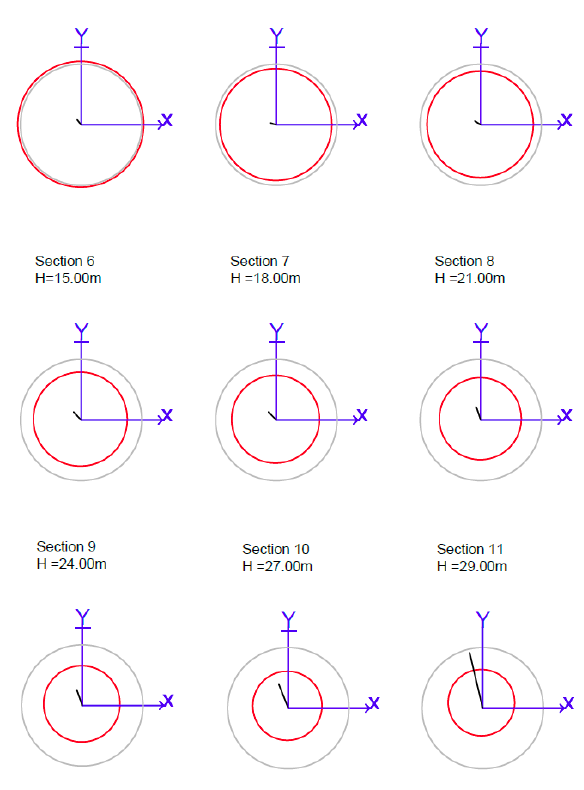
Figure 5. Some images of the schemes used to represent verticality deviations. Original images also have numerical information about the displacement. Numerical results are omitted in this paper.